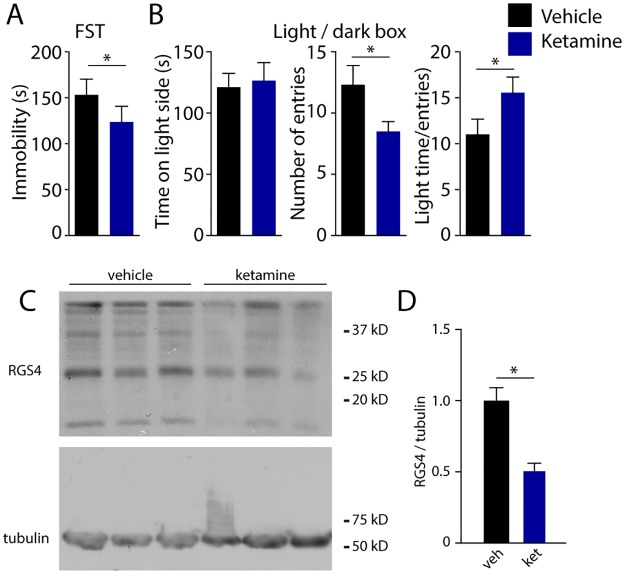
Acute ketamine treatment decreases depression-like behavior and reduces prefrontal RGS4 levels.(A) Bars show mean immobility times in forced swim test (FST). (B) Bar graph showing results of light / dark box test. Left: mean time spent in the brightly lit compartment, middle: number of entries to the bright compartment, right: ration of time spent in light and the number of entries. *: p < 0.05, paired t-test. (C) Example western blot of RGS4 and β-tubulin in vehicle- versus ketamine- treated mice. (D) Quantification of RGS4 levels in vehicle (black) and ketamine (blue) treated mice. Bars show mean ± SEM, *: p<0.05, unpaired t-test.